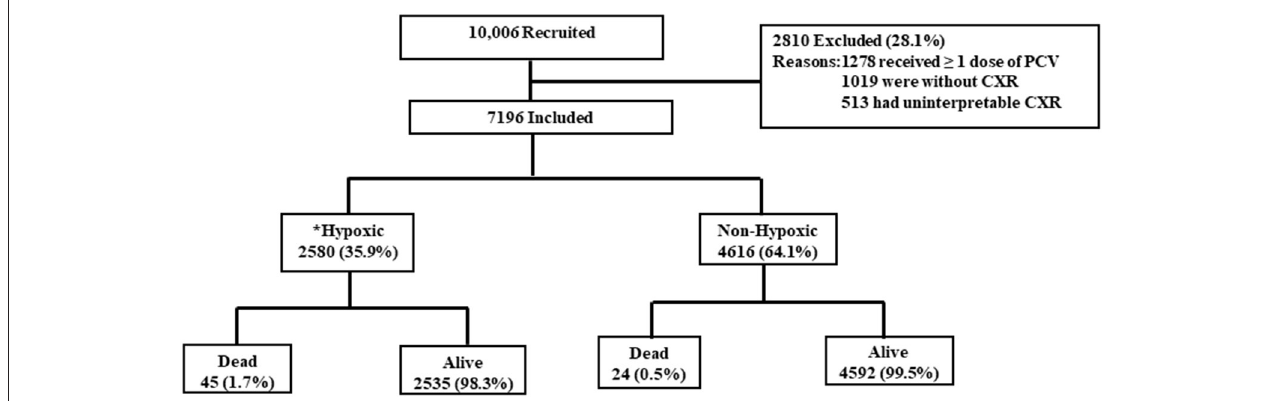
FIGURE 1 | Children (2–59 months) hospitalized with community-acquired pneumonia from 2015 to